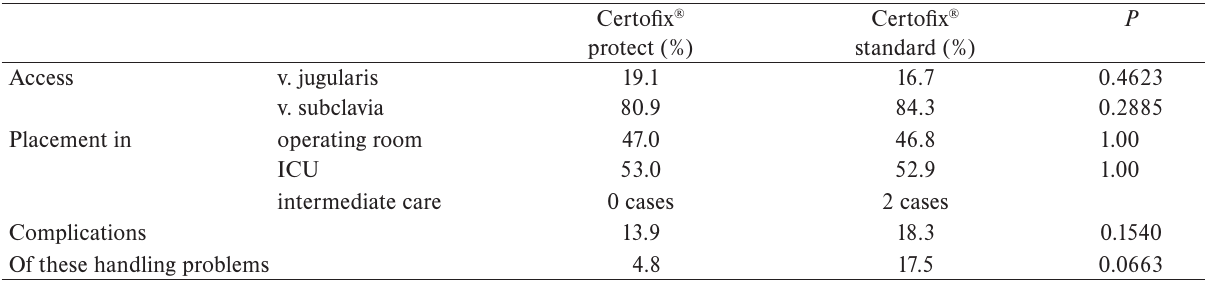
Table 2. Catheter parameters related to placement in the Certofix ® protect and Certofix ® standard